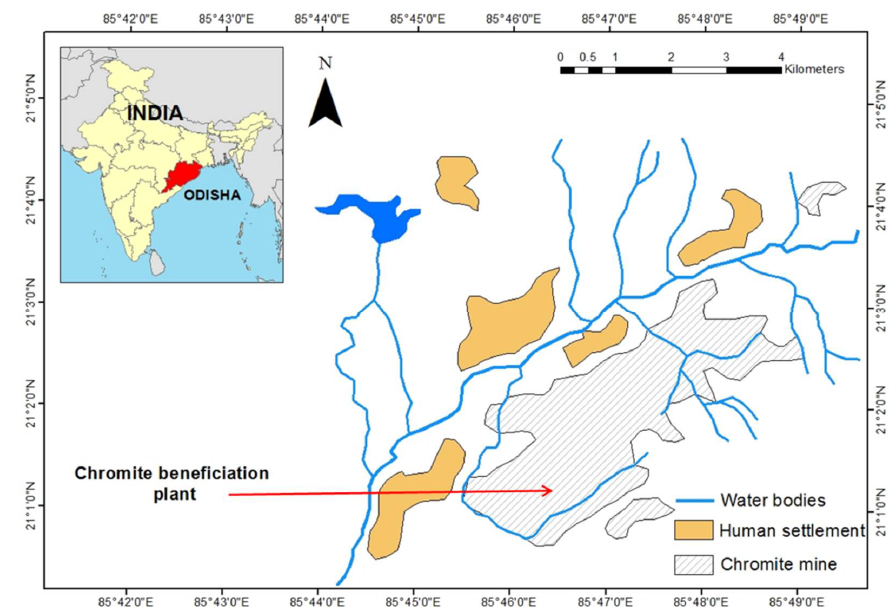
Figure 1. Chromite mine in Sukinda valley (Odisha, India).